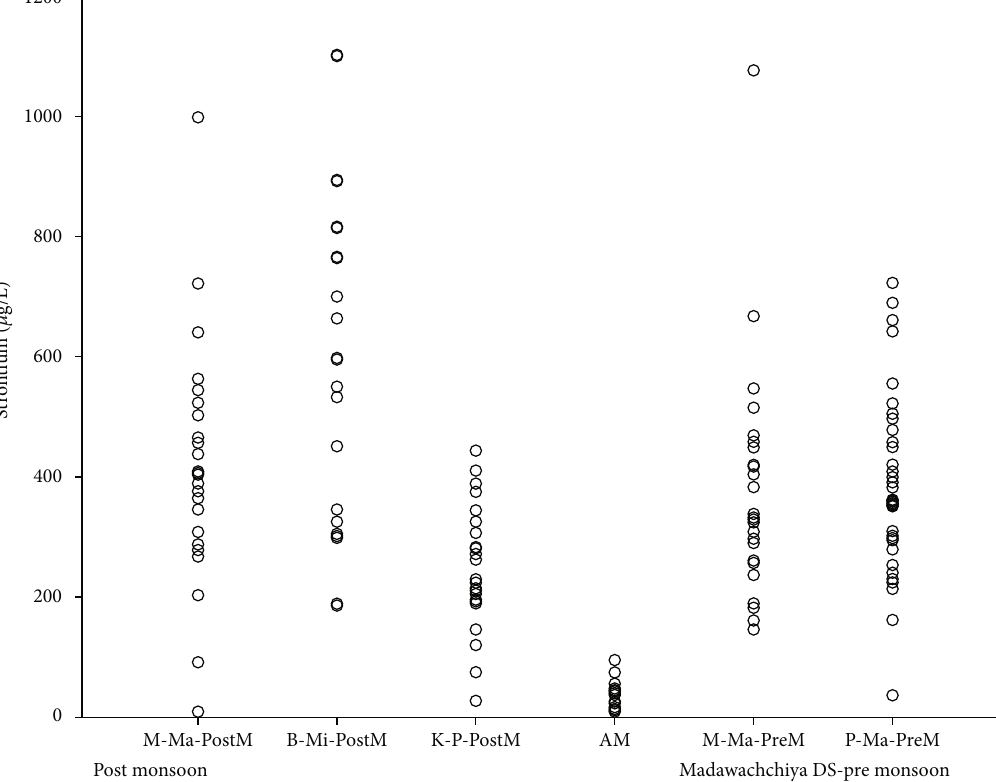
Figure 5: Strontium content of well water samples in the study